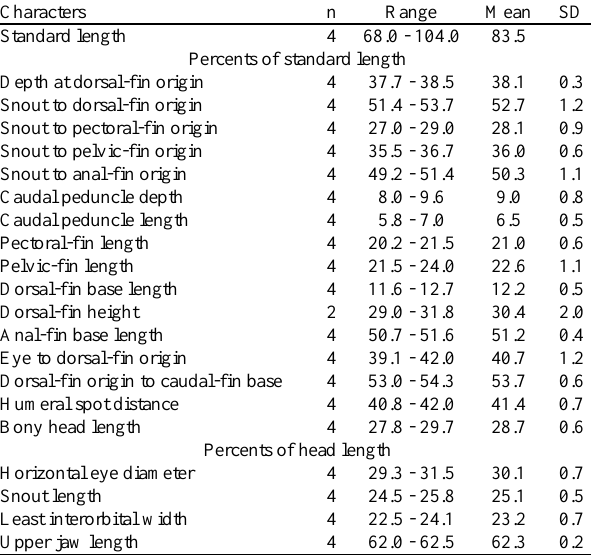
Table 1 . Morphometrics of Charax apurensis . Specimens are from MZUSP 27947, 40699 and